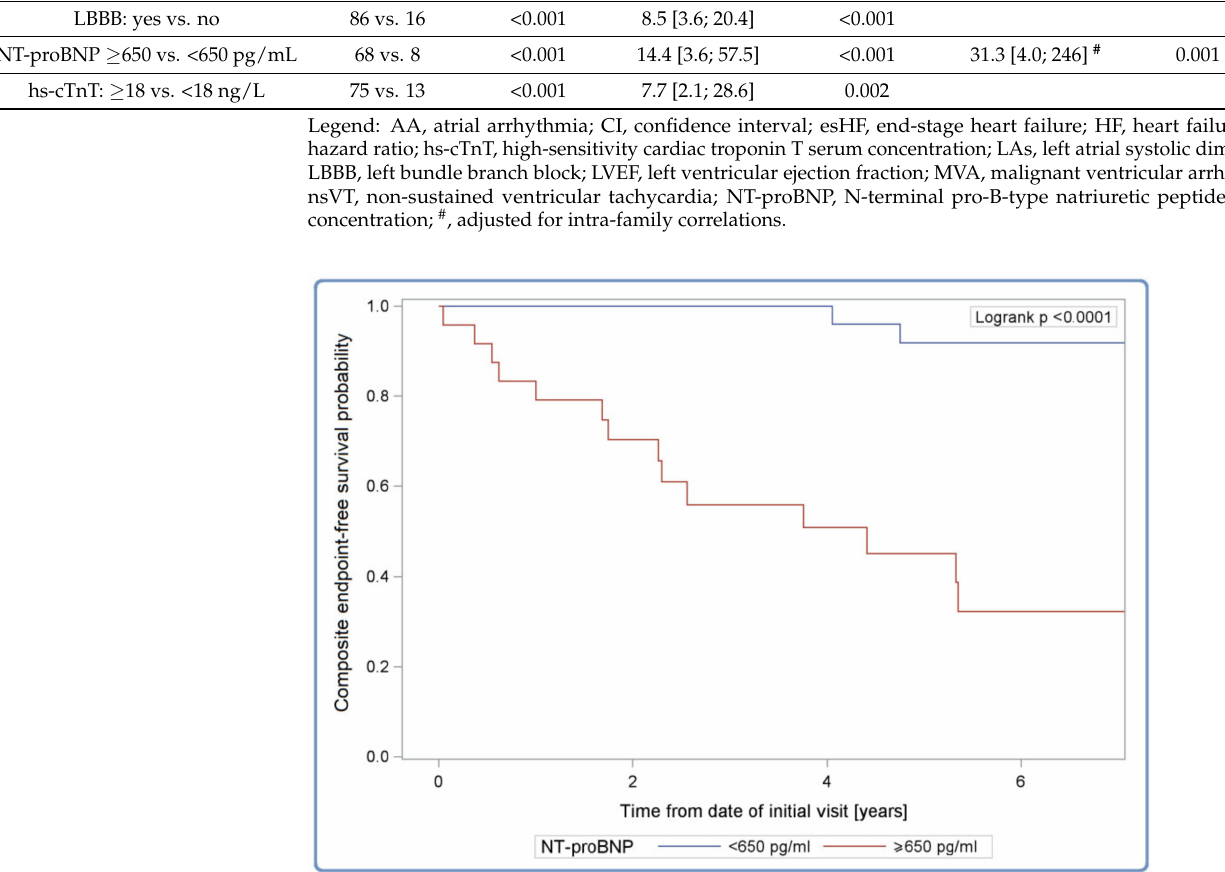
Figure 3. Kaplan–Meier composite endpoint-free survival curves in cardiotitinopathy according to NT-proBNP serum concentration. Legend: NT-proBNP, N-terminal pro-B-type natriuretic peptide serum